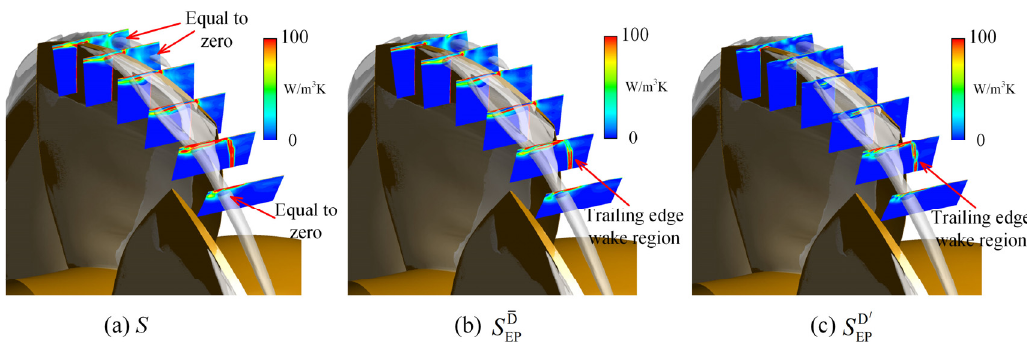
Figure 9. Contours of entropy production and the two components of viscous dissipation and turbulent dissipation.